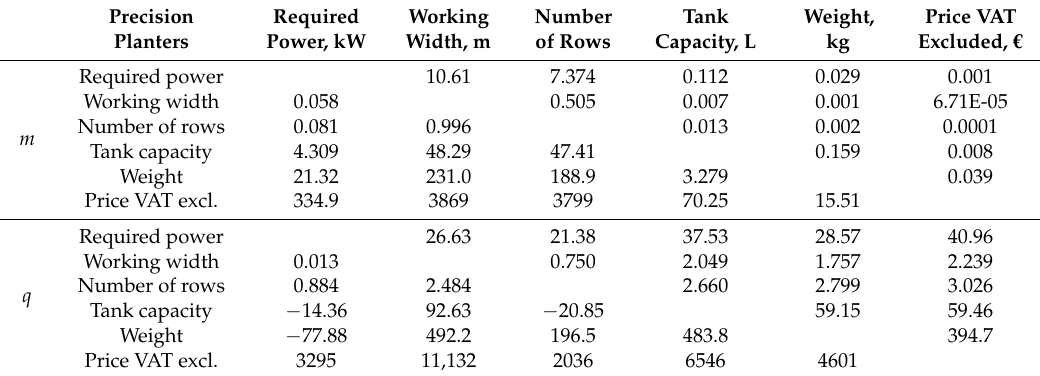
Table 10. Linear coefficient and intercept matrix for functional parameters of precision